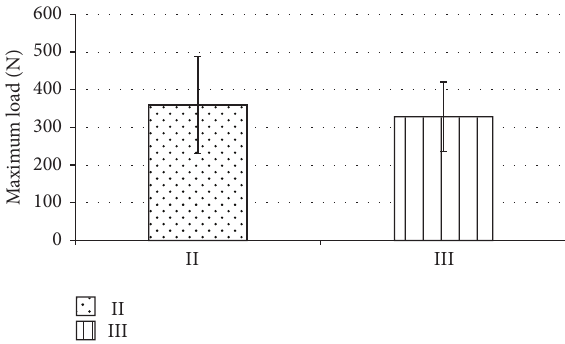
Figure 2: The maximum load (load-to-failure after cyclic loading) was determined for group II (bicortical nonlocking plate) and group III (monocortical locking plate). No statistically significant difference was found.